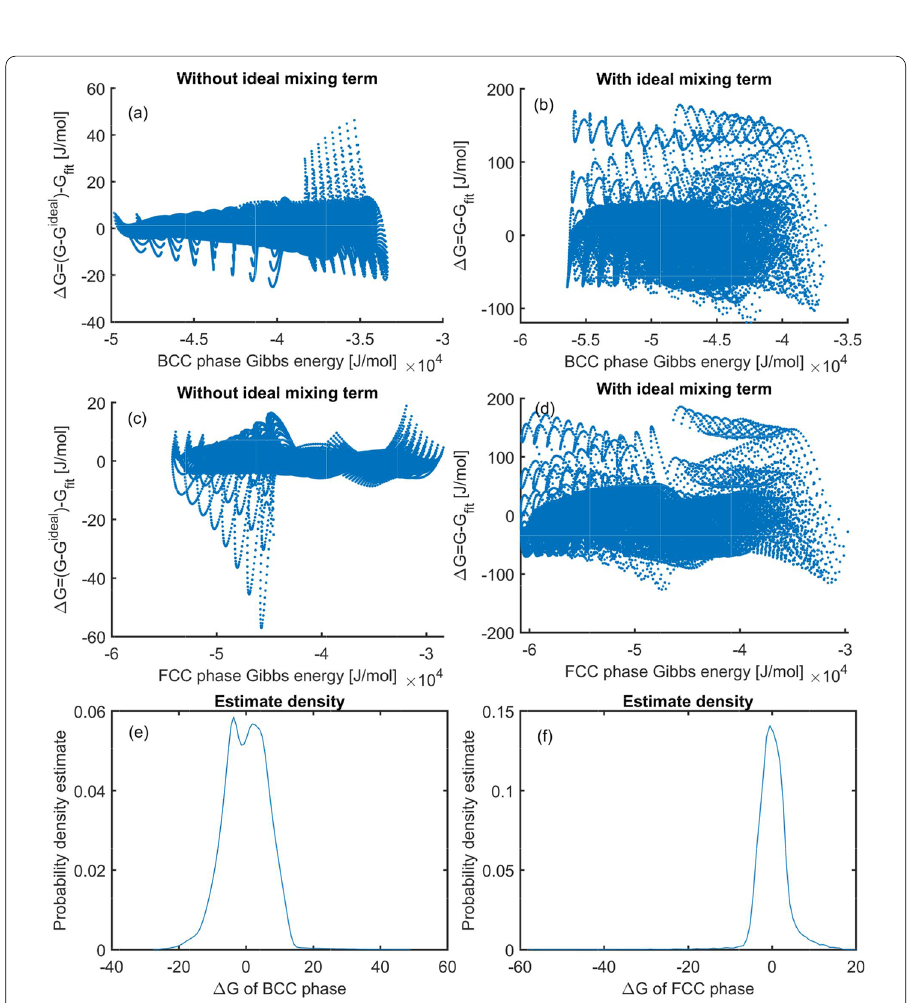
Fig. 2 Scatter plot of △ G as a function of G taking the ideal mixing term into account for ( b ) BCC (d) FCC and when the ideal mixing term is subtracted for ( a ) BCC ( c ) FCC, Line plot of probability density estimate for BCC ( e ) and FCC ( f ) without ideal mixing